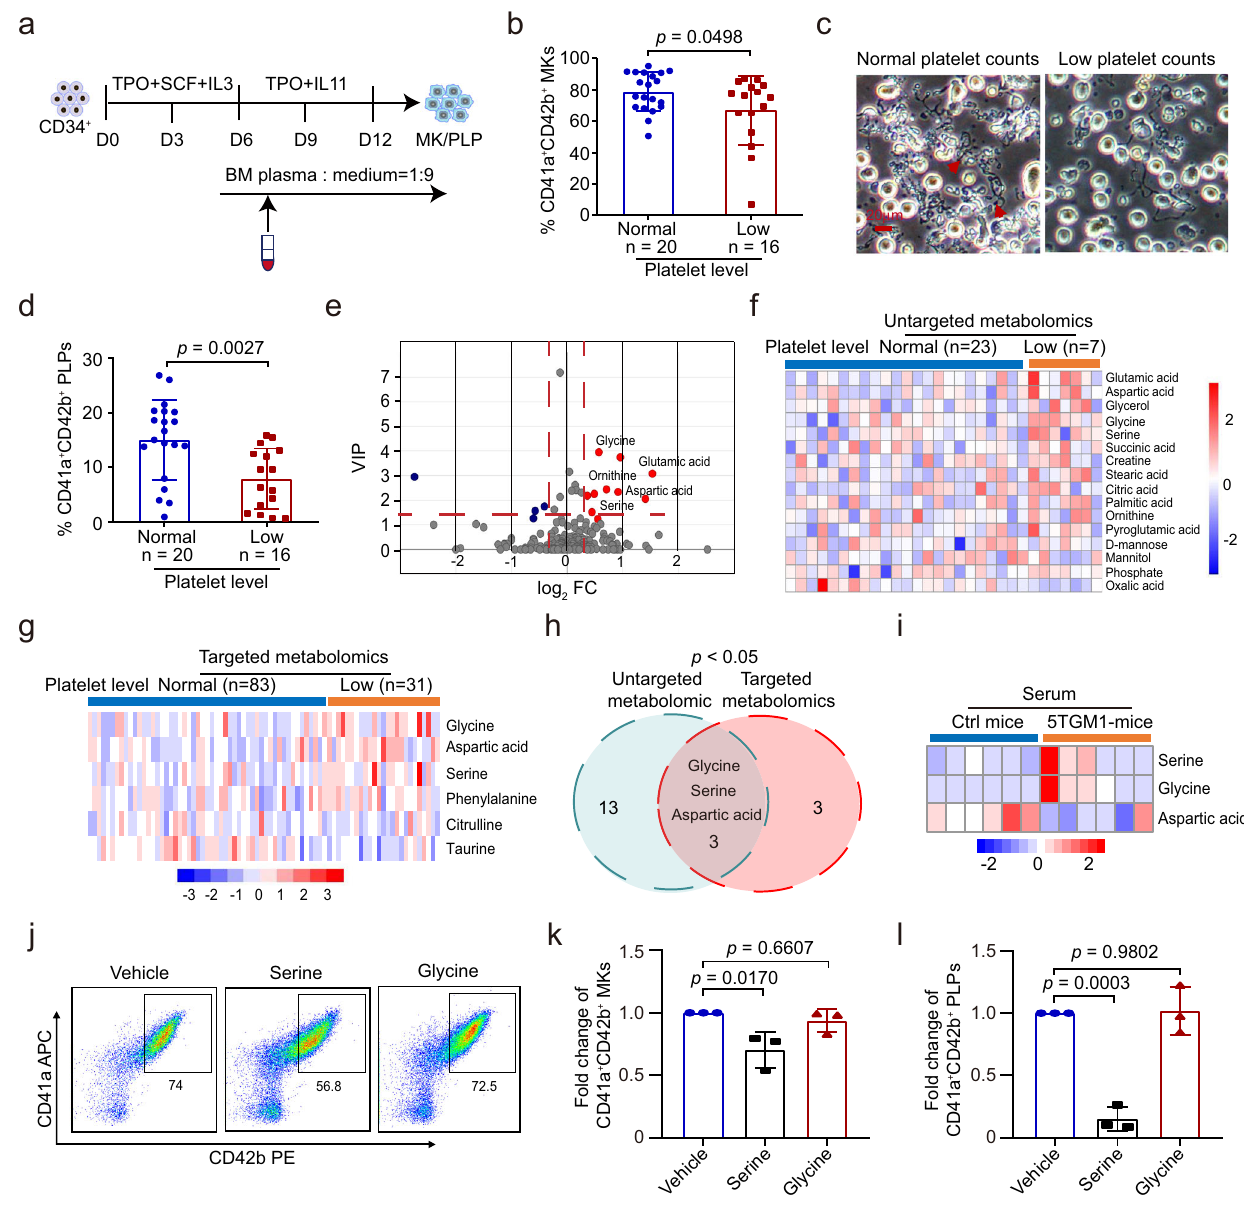
Fig. 2 | Serine is upregulated in BM and linked to thrombocytopenia in MM. a Schematic diagram showing megakaryocytic differentiation of CD34 + cells trea- ted with BMplasma derivedfrom MMpatients with or without thrombocytopenia. b Flow cytometry analysis of the percentage of CD41a + CD42b + cells at day 12 of megakaryocyticdifferentiationwithBMplasmatreatment(mean±SD, n MM normal = 20, n MM low = 16). c Phase-contrast images of proplatelet formation at day 12 from CD34 + cells with BM plasma treatment (scale bar, 20 μ m). d Generation of CD41a + CD42b + PLPs at day 12 of CD34 + cells with BM plasma treatment (mean±SD). e Volcano plot of differentialmetabolites in BMplasma between MM patients with normal-platelet counts ( n = 23) and patients with low-platelet counts ( n = 7) by using with un-targeted metabolomics. Signi fi cantly upregulated metabolites are represented as ‘ red ’ dots,and downregulatedmetabolitesare representedas ‘ blue ’ dots. f Heatmaps of the 16 differential metabolites in BM plasma between MM patients with normal platelet counts and with low platelet counts. g Heatmaps of